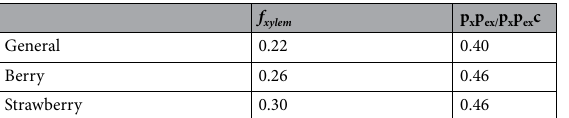
Table 1. Values of the model parameters ( f xylem and p x p ex/ p x p ex c) used for the simulations of strawberry bulk dried tissue δ 18 O